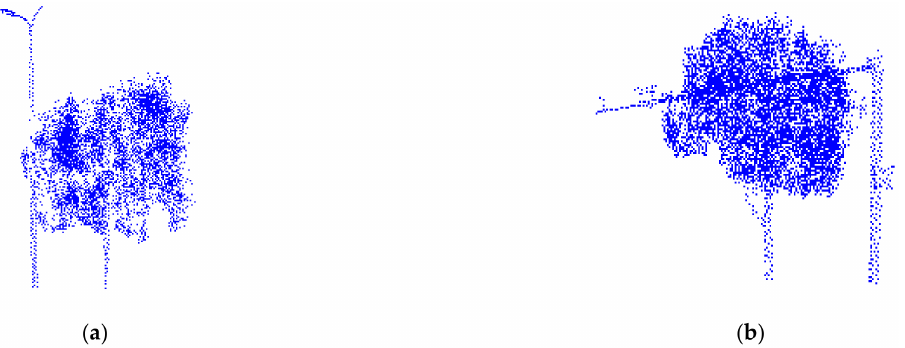
Figure 10. Overlapping region extraction. Here, ( a ) represent the situation where is a shade between the tree and the lamp, ( b ) represent the situation where is a shade between tree and traffic light.